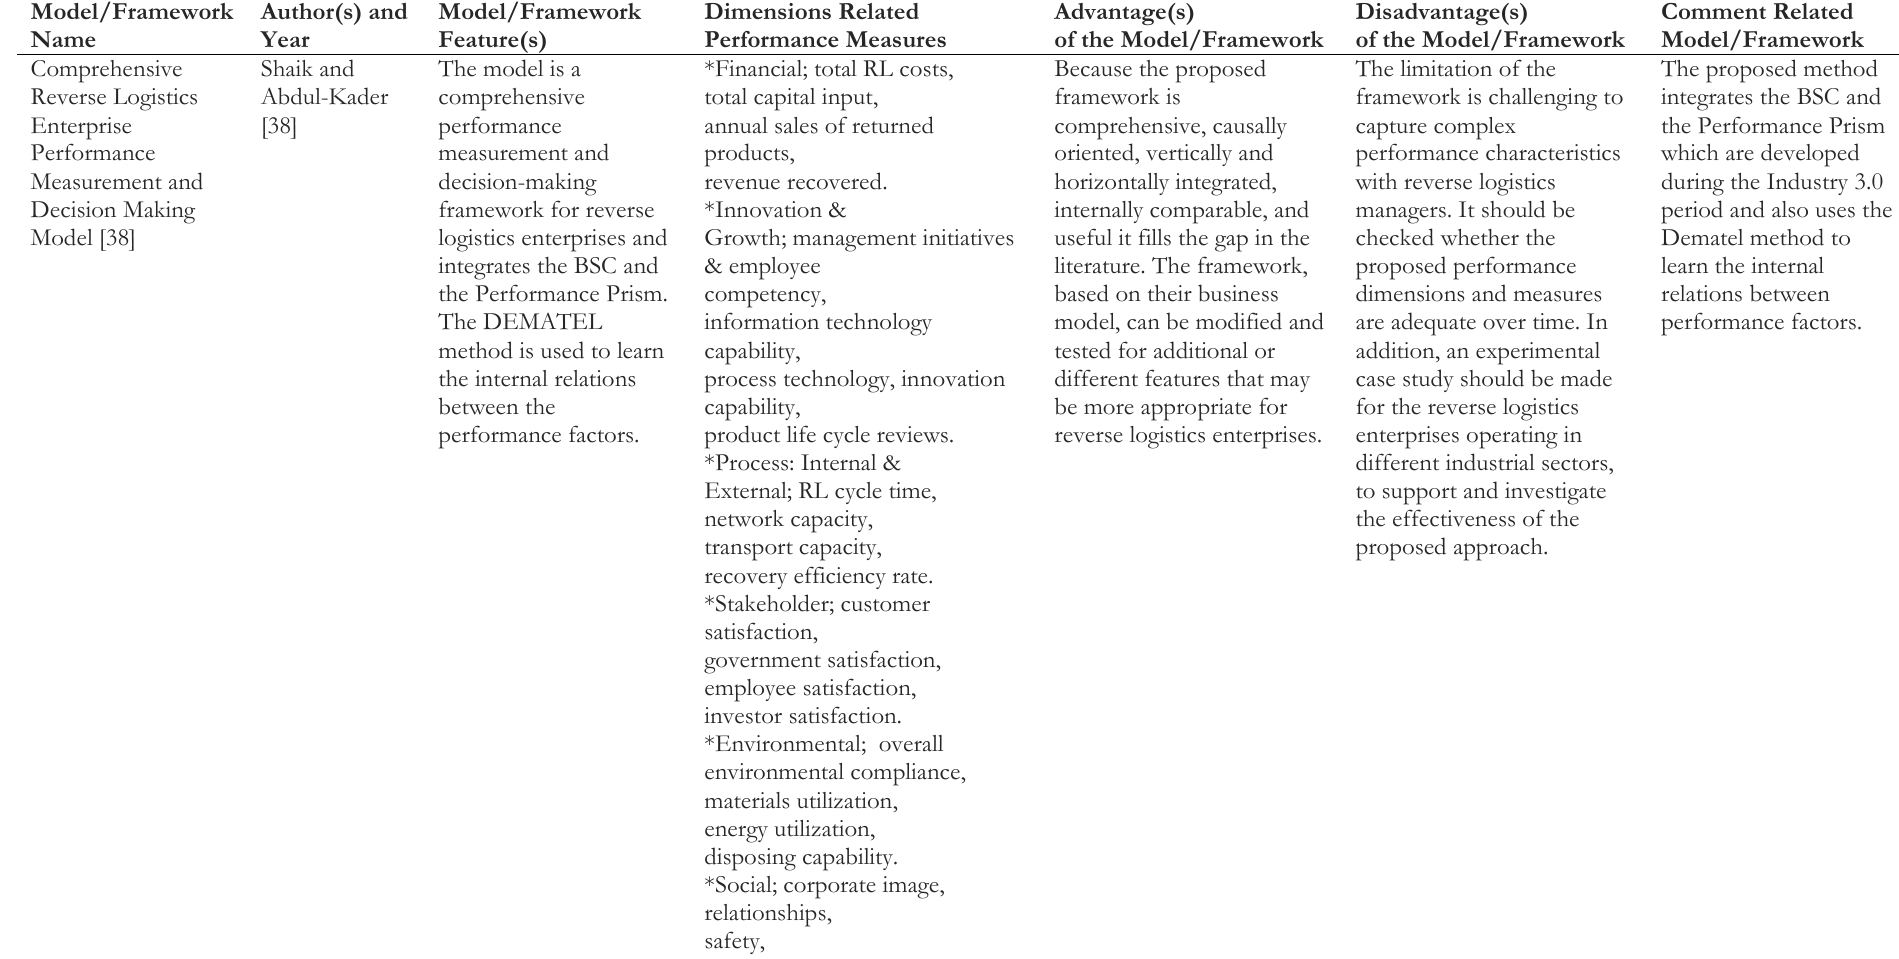
Table 16. Organizational performance measurement models developed in Industry